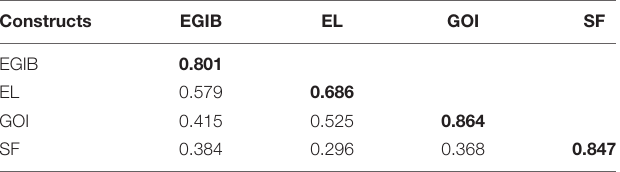
TABLE 3 | Fornell-Larcker criterion.